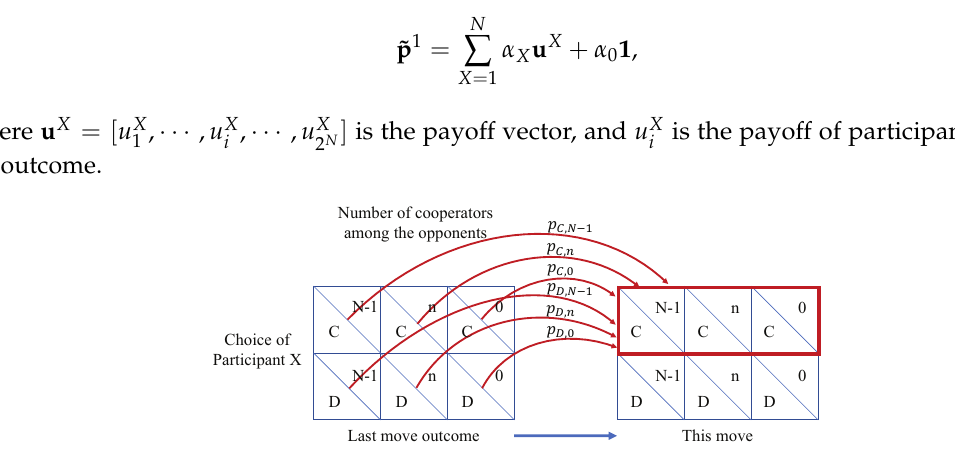
Figure 1. The iterated processing in the game